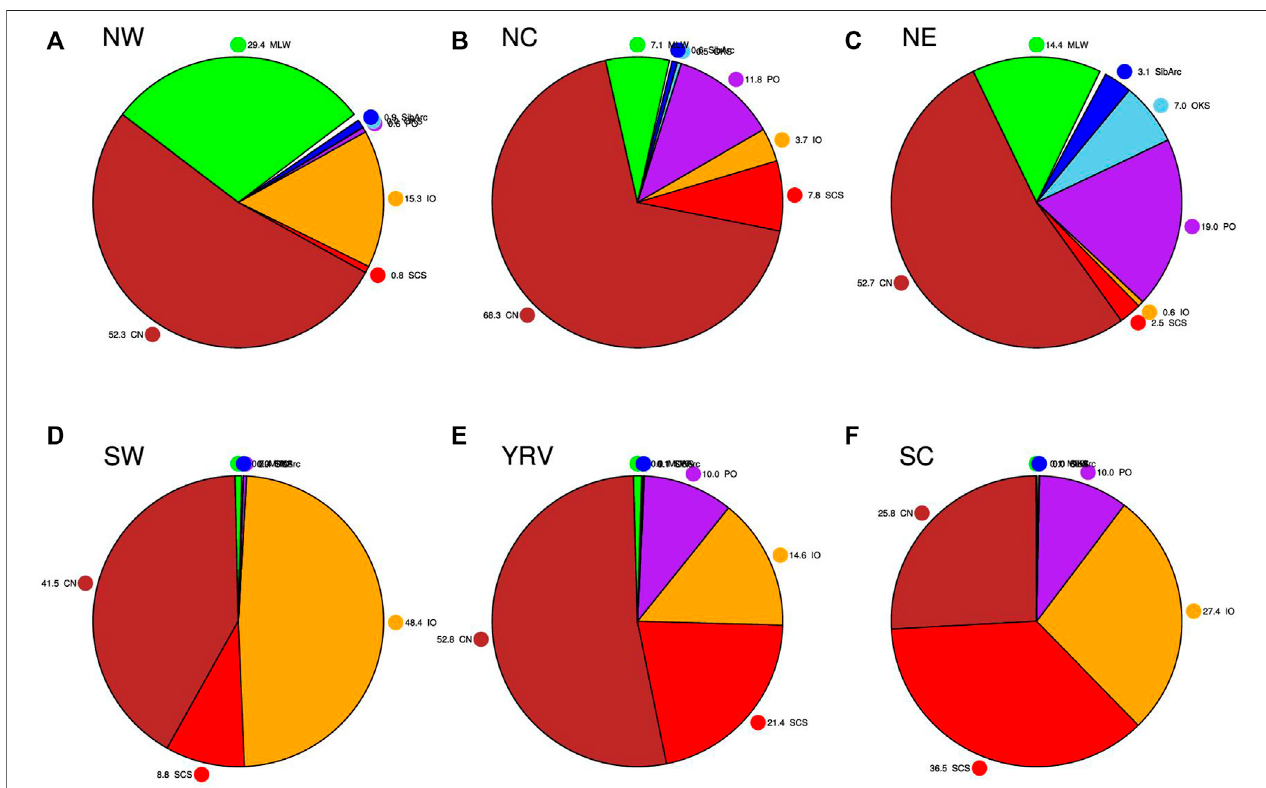
FIGURE2| Piechartoftherelativecontributionsofthesevenmoisturesourcestototalprecipitationinthesixsubregions: (A) NW, (B) NC, (C) NE, (D) SW, (E) YRV, and (F) SC.